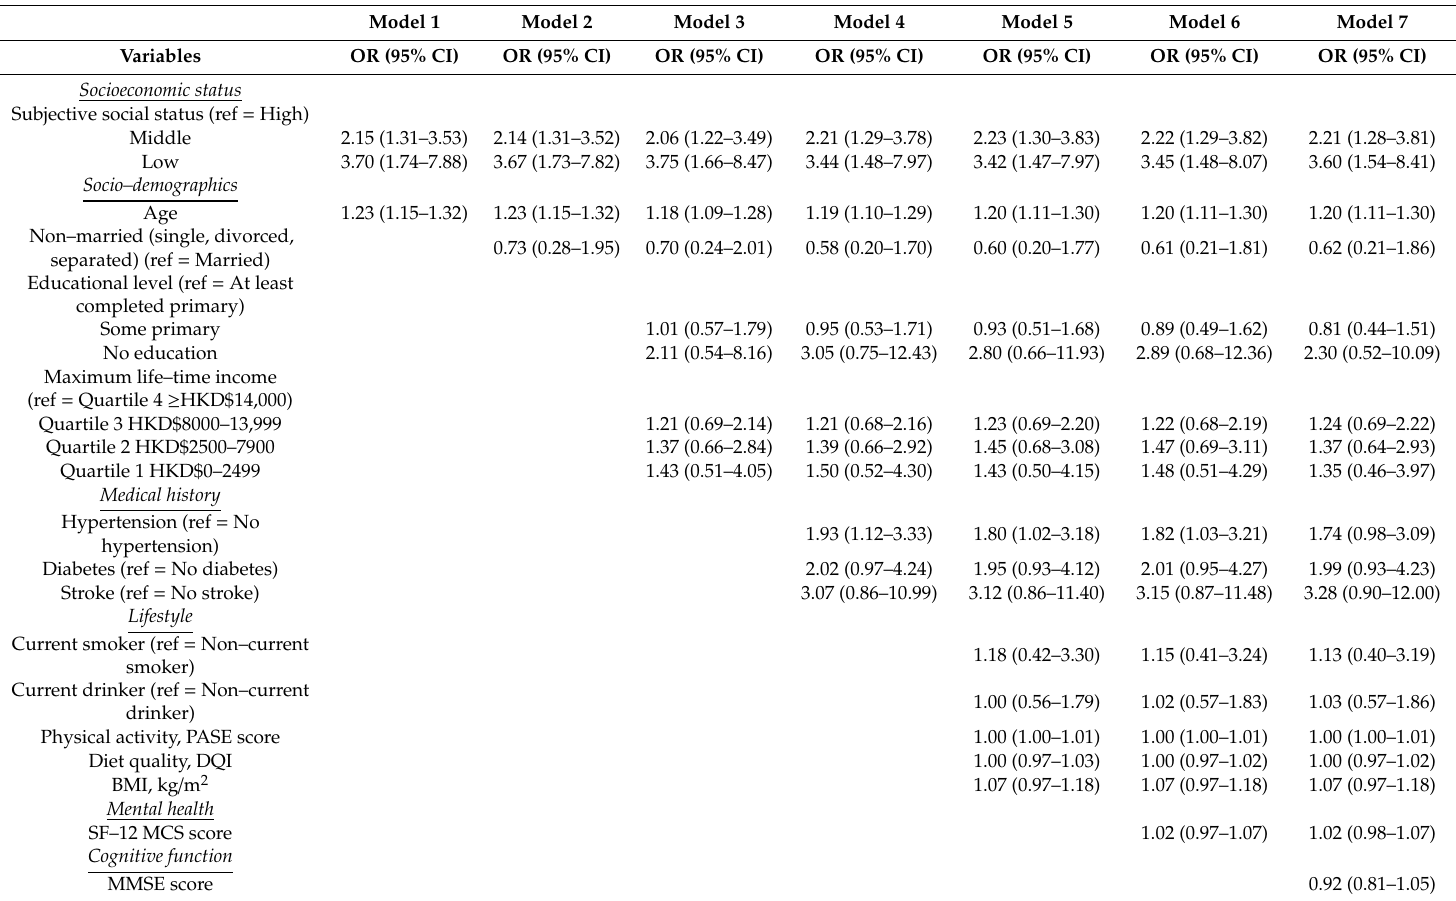
Table 4. Subjective social status (community status ladder) at baseline and the risk of incident frailty at 14-year follow-up, men (n =